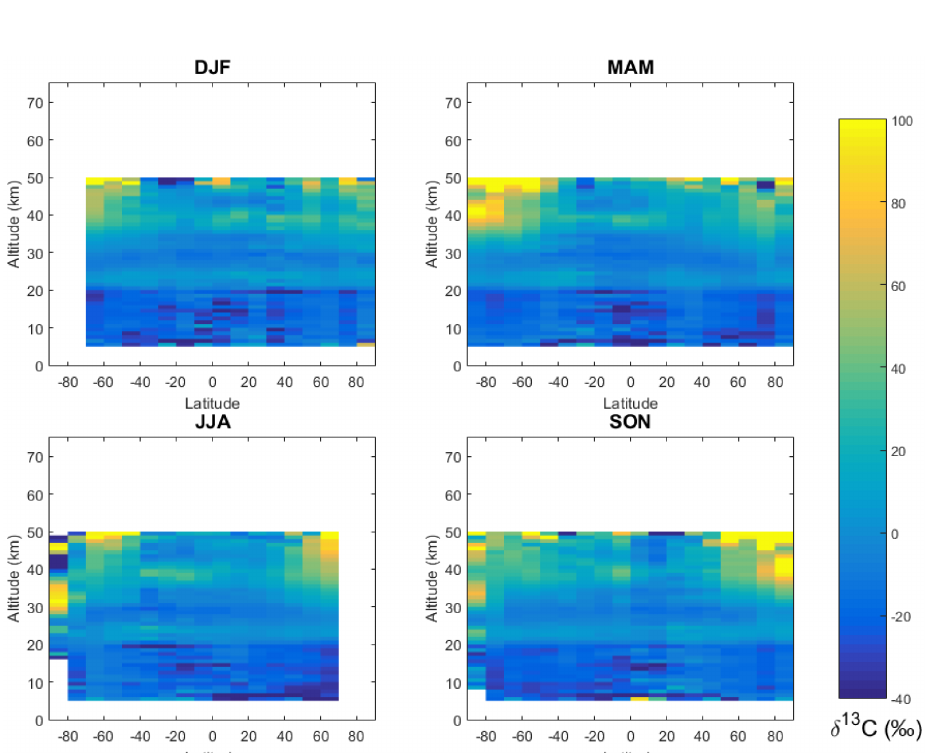
Figure 5. ACE δ 13 C by